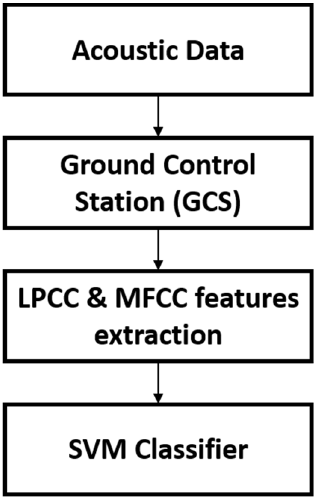
Figure 4. Overall system diagram of the approach presented in [38] .